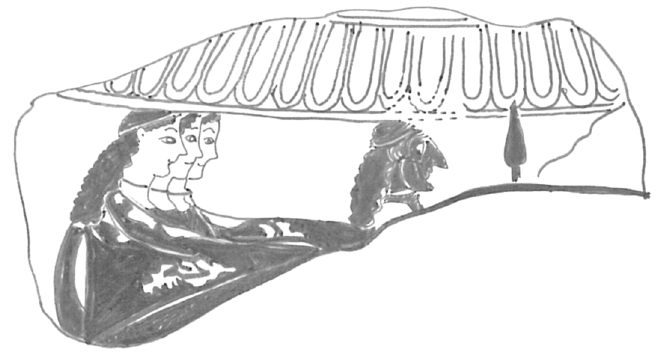
Figure 1. Fragment of a Corinthian column crater. The Hague, Scheurleer Museum inv. 2034. (Drawing by the author).